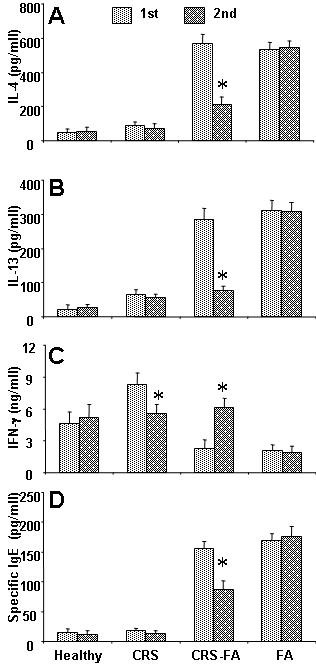
Th2 cytokines and IgE levels were decreased in the sera of patients with CRS-FA after the sinus surgery. Th1/Th2 cytokines and specific IgE were measured with ELISA as detailed in the text. Bars represent levels of cytokines or IgE in the sera. Data are expressed as mean ± SD. *, p < 0.05, compared with values of the 1st tests (before surgery).